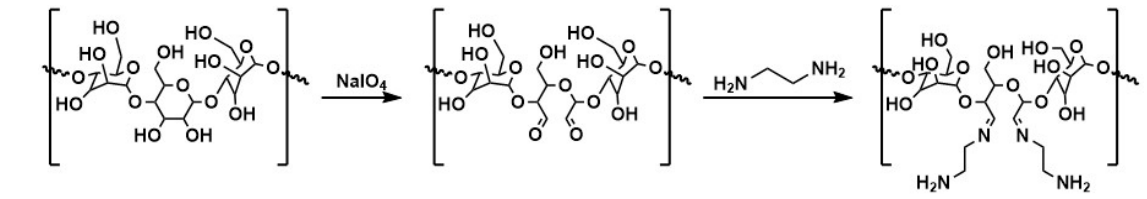
Figure 22. Synthesis of aminated starch.